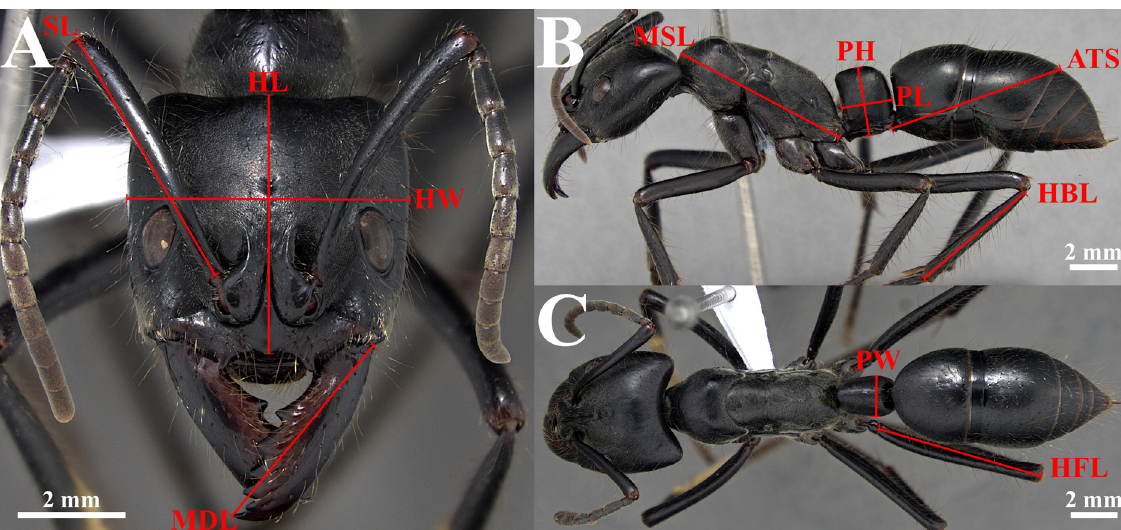
(DZUP 549811). A . Full-face view. ☿